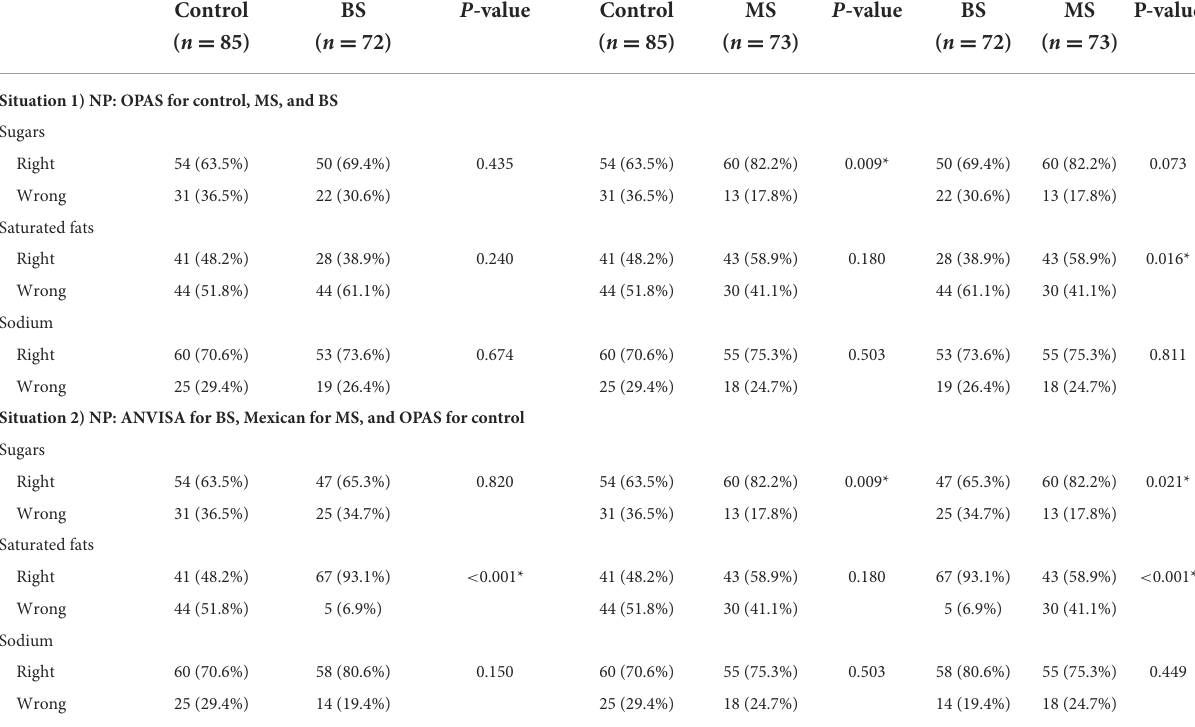
TABLE 6 Right and wrong answers about nutrient content, by study arm, considering different nutritional profile models. In your opinion, does the scanned product contain any excessive nutrients or any substance that could harm a healthy diet?